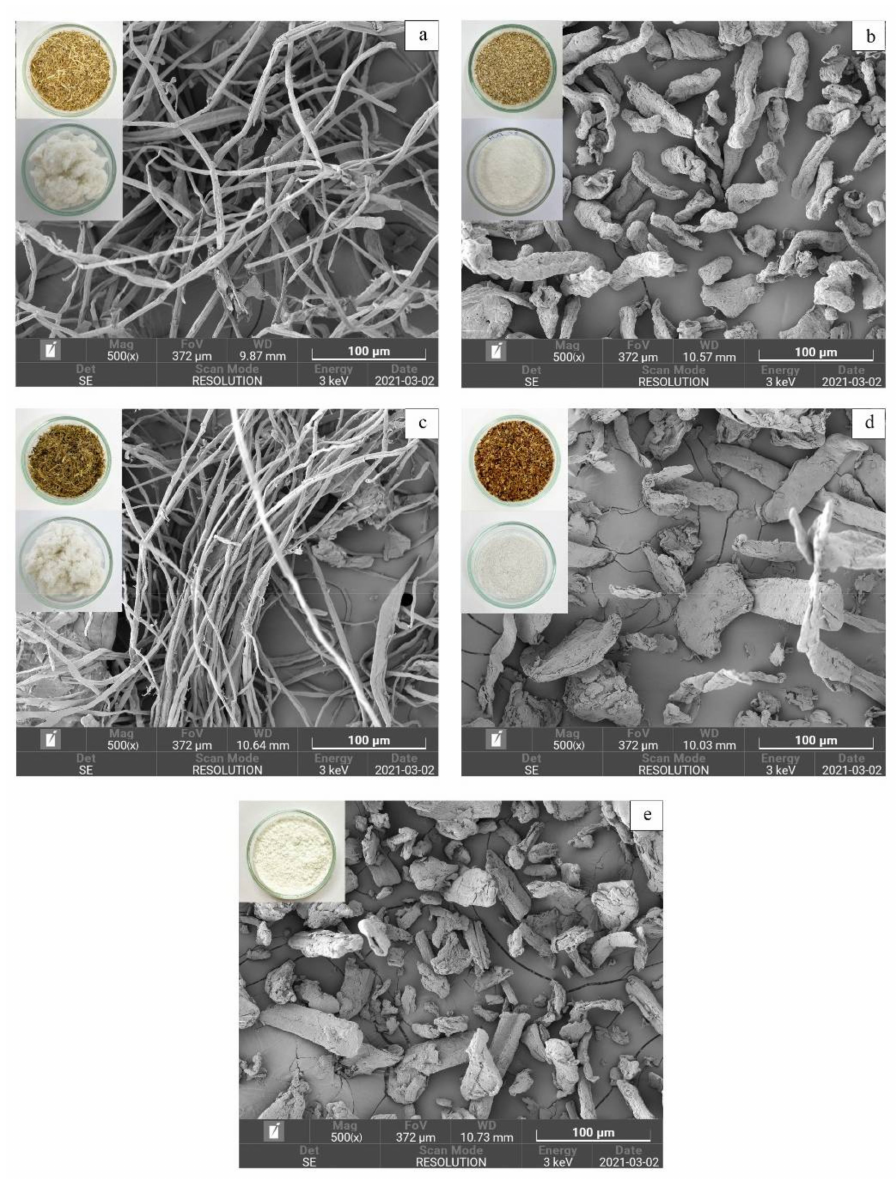
Figure 1. Scanning electron micrographs of cellulose samples with the alkaline processing of agri- cultural waste materials and their comparison with the commercial cellulose. ( a ) AE-RSC: Alkaline extraction of rice straw cellulose; ( b ) AE-CCC: Alkaline extraction of corncob cellulose; ( c ) AE-PLC: Alkaline extraction of pineapple leaf cellulose; ( d ) AE-PPC: Alkaline extraction of pineapple peels cellulose; and ( e ) COM-C: Commercial